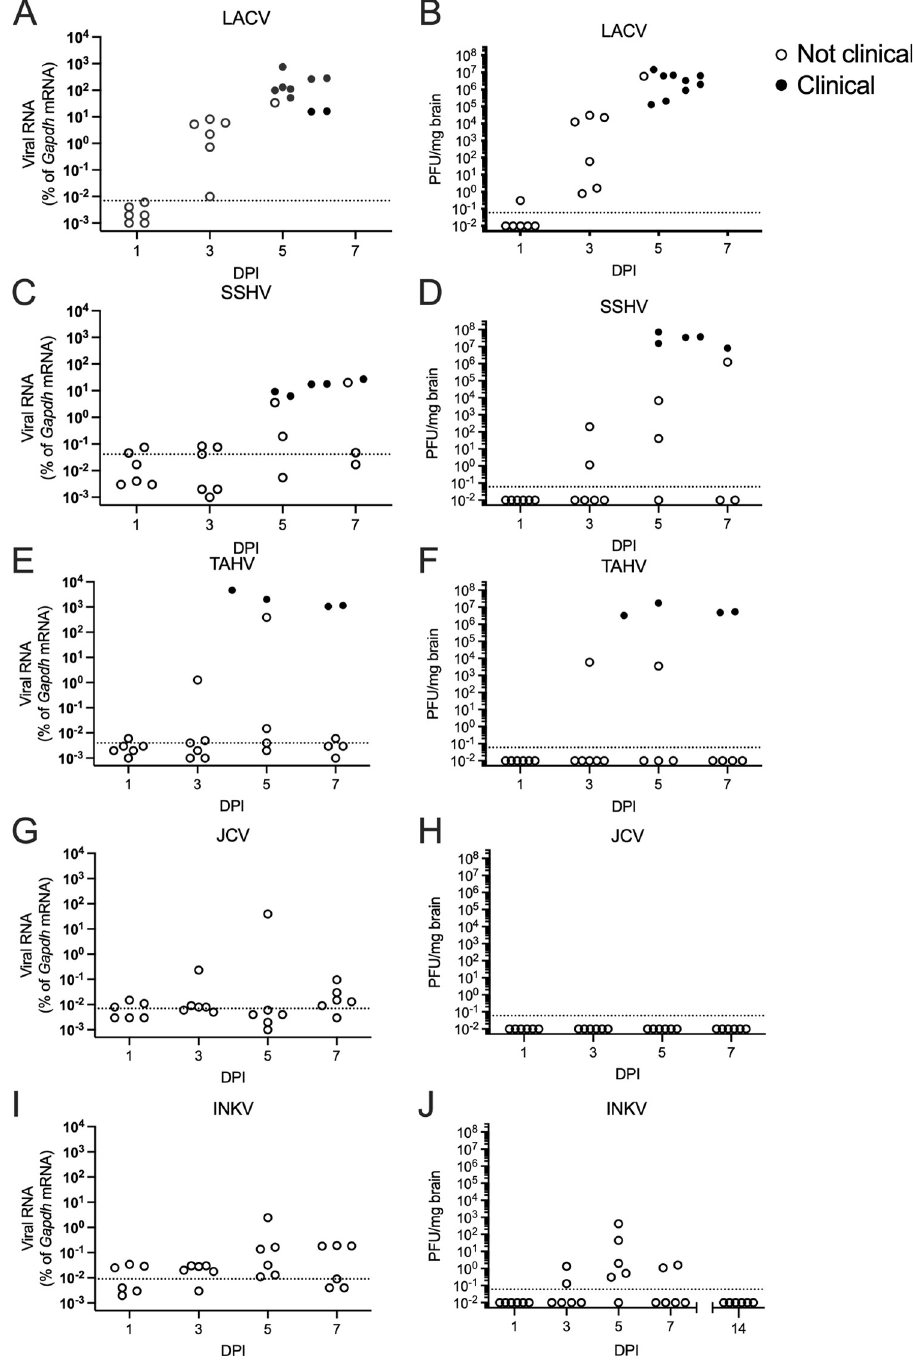
Fig 1. Neuroinvasion of the CSG viruses. A, C, E, G, I) Brain tissue was evaluated for viral RNA via RT-qPCR with virus-specific primers. Dotted lines indicate mock sample average from n = 4. B, D, F, H, J) Brain tissues were evaluated for infectious virus via plaque assays of brain homogenates in Vero cells. Dotted lines represent the limit of detection. No plaques were detected in any mock controls, n = 4. Individual dots represent individual mice. For all viruses and time points, n = 6, except for: LACV n = 4 for 6 dpi, no mice survived to 7 dpi; SSHV n = 5 for 5 dpi, two of the designated 7 dpi mice developed neurological disease at 6 dpi and had to be euthanized, so n = 2 for 6 dpi, n = 4 for 7 dpi; for TAHV, one mouse in the 5 dpi group developed neurological disease at 4 dpi and had to be euthanized, so n = 1 for 4 dpi and n = 5 for 5 dpi. (G) Dunnett’s multiple comparisons tests was done for JCV viral RNA compared to mock, using Log2(%gapdh) values. Nonclinical = mice with no signs of disease; Clinical = mice displaying neurological signs or other endpoint criteria as described in the methods. https://doi.org/10.1371/journal.ppat.1010384.g001 PLOS Pathogens| https://doi.org/10.1371/journal.ppat.1010384 March 4,